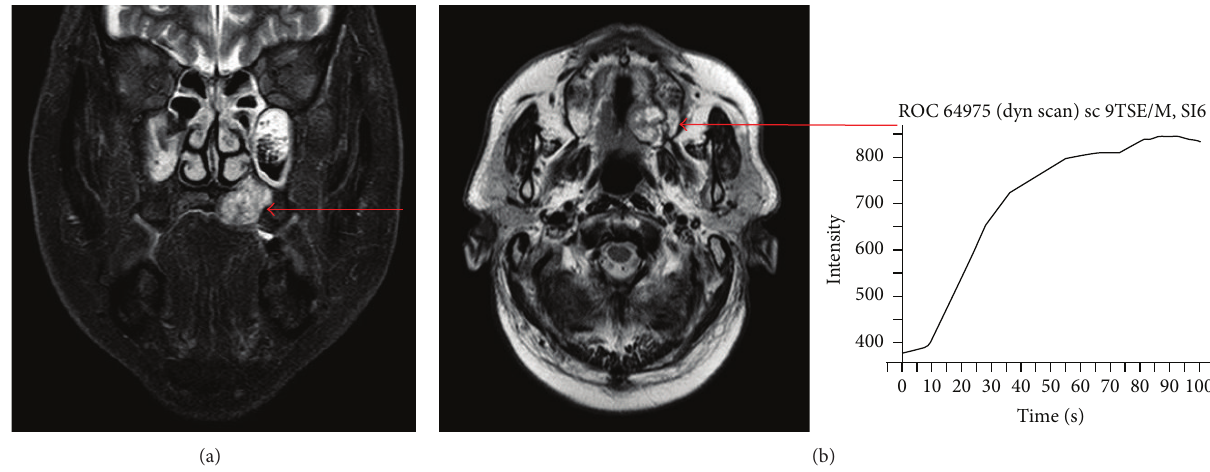
Figure 3: MR images. (a) Frontal plane section. (b) Horizontal section. CE-MRI showed that the mass extended upward and invaded the nasal cavity. The mass showed hypointensity on T1-weighted images, hyperintensity on T2-weighted images, and an irregular margin with internal enhancement. Dynamic MRI revealed a plateau type lesion that was suspected to be a malignant tumor.